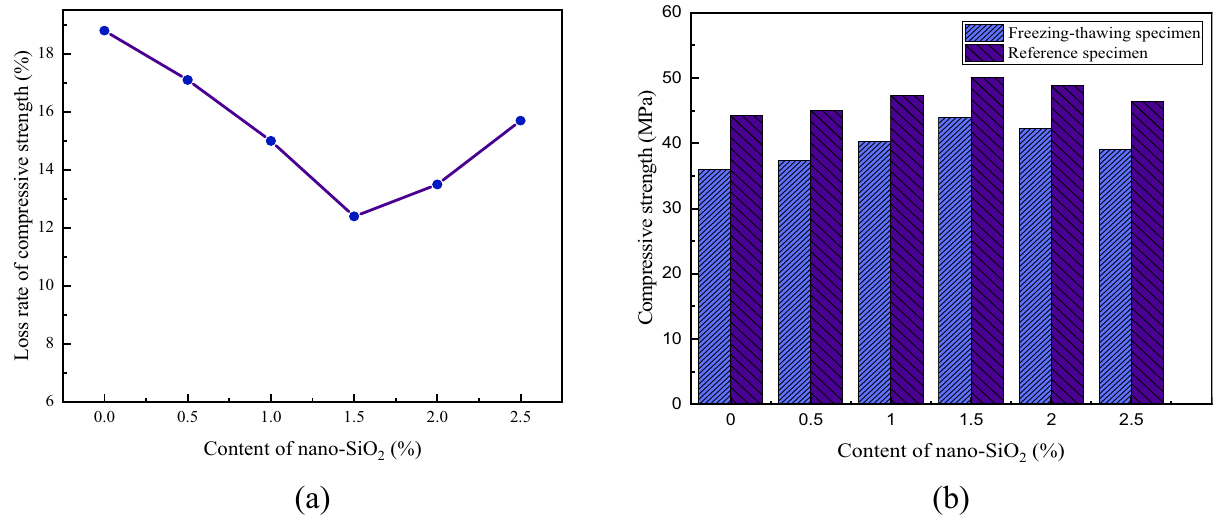
Figure 23: E ff ect of nano - SiO 2 content on the freezing - thawing resistance of geopolymer [ 99 ] . ( a ) The loss rate of compressive strength and ( b ) compressive